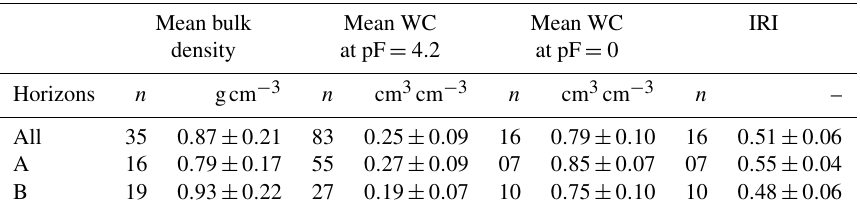
Table 3. Main physical parameters of selected soil horizons.